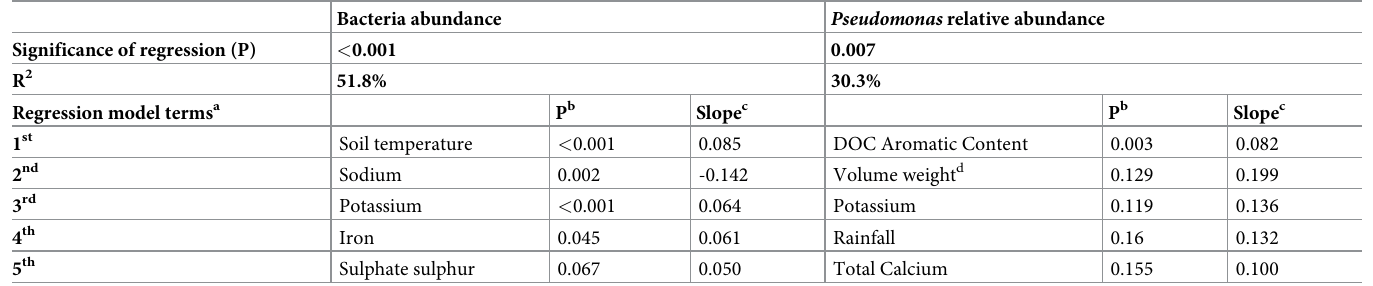
Table 2. Edaphic and environmental properties influencing microbial community